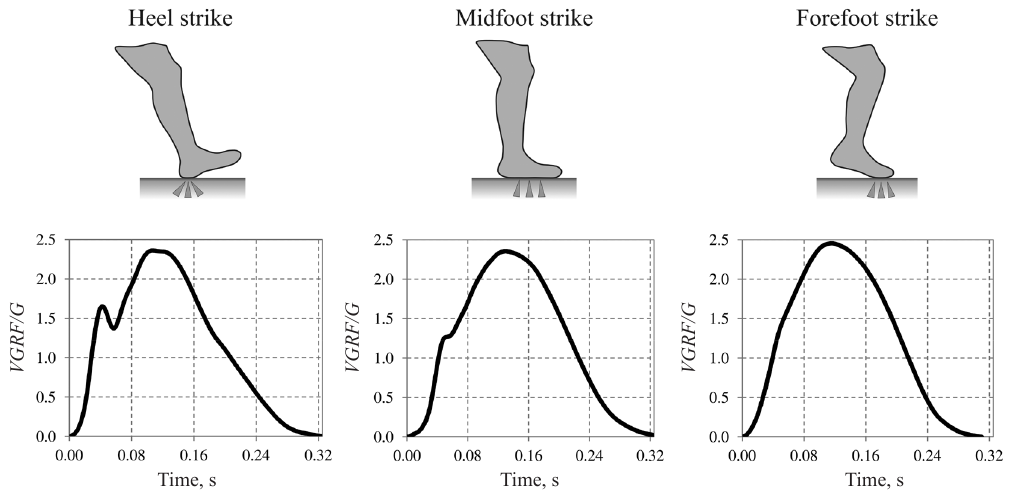
Figure 2. Foot strike patterns during running and corresponding normalised vertical ground reaction forces ( VGRF / G